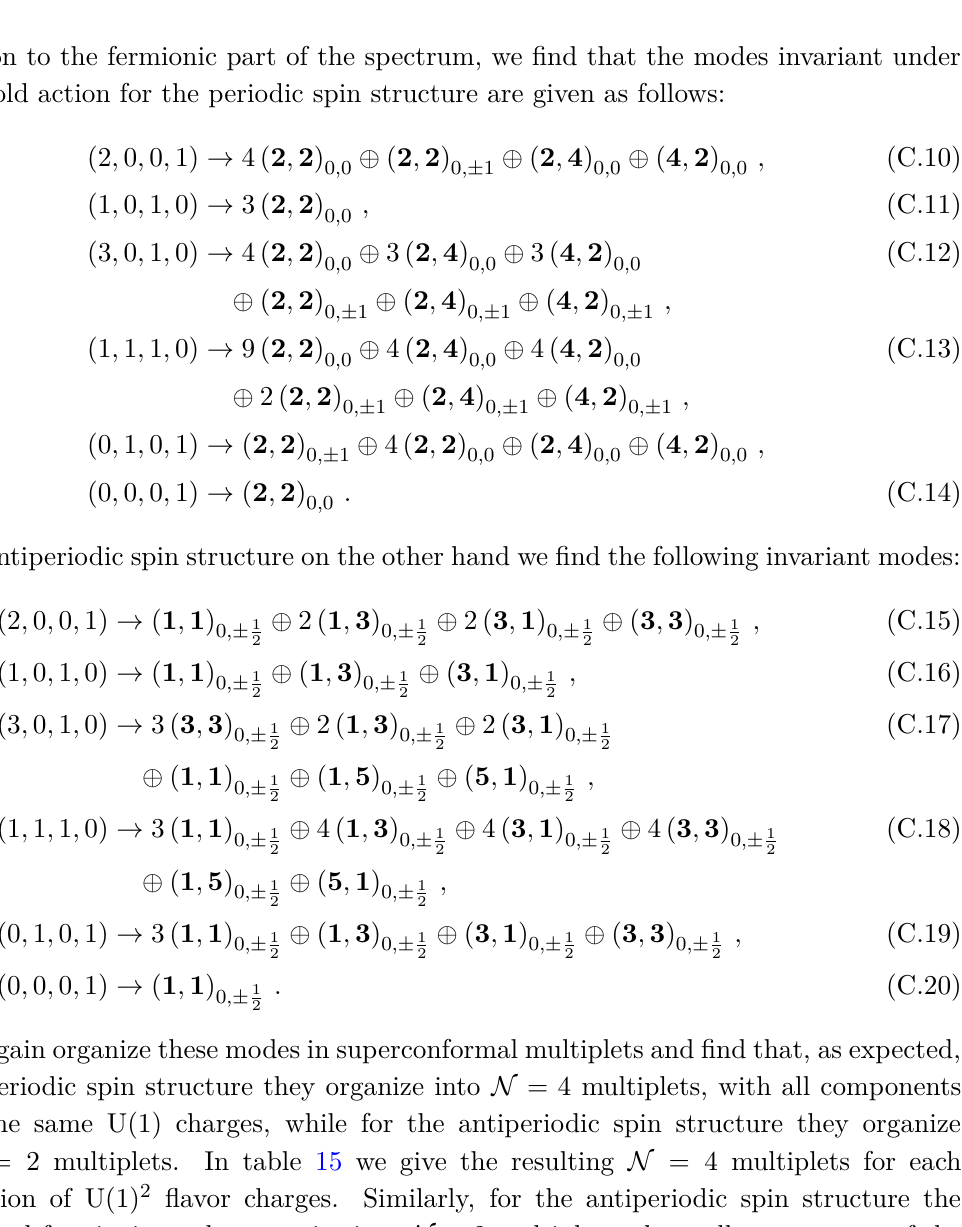
Table 15 . The N = 4 multiplets from the KK spectrum at level n = 2 for the periodic spin structure. The U(1) × U(1) charges are presented in the left column while the SU(2) 1 × SU(2) 2 SU(4) representations are indicated on each